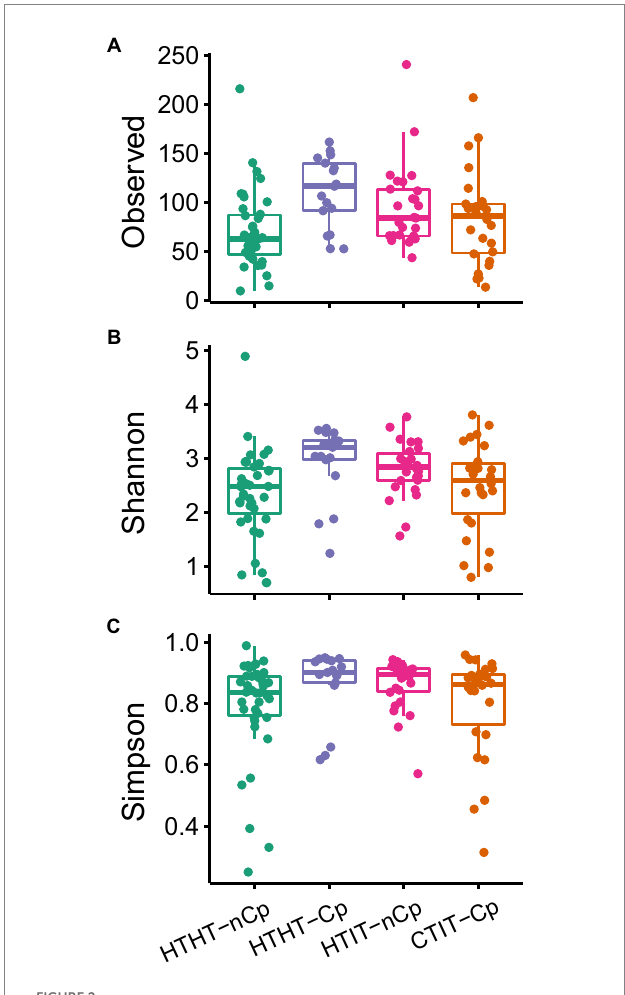
FIGURE 2 (A) Observed number of OTUs, (B) Shannon diversity, and (C) Simpson’s diversity index for fungal communities of HTHT-nCp (healthy tissue from healthy trees without C. parasitica ), HTHT-Cp (healthy tissue from healthy trees with latent C. parasitica infection), HTIT-nCp (healthy tissue from C. parasitica infected trees) and CTIT-Cp (canker tissue from C. parasitica infected trees). Differences between the sample types were determined by the Dunn’s Kruskal–Wallis test for multiple comparisons, p <